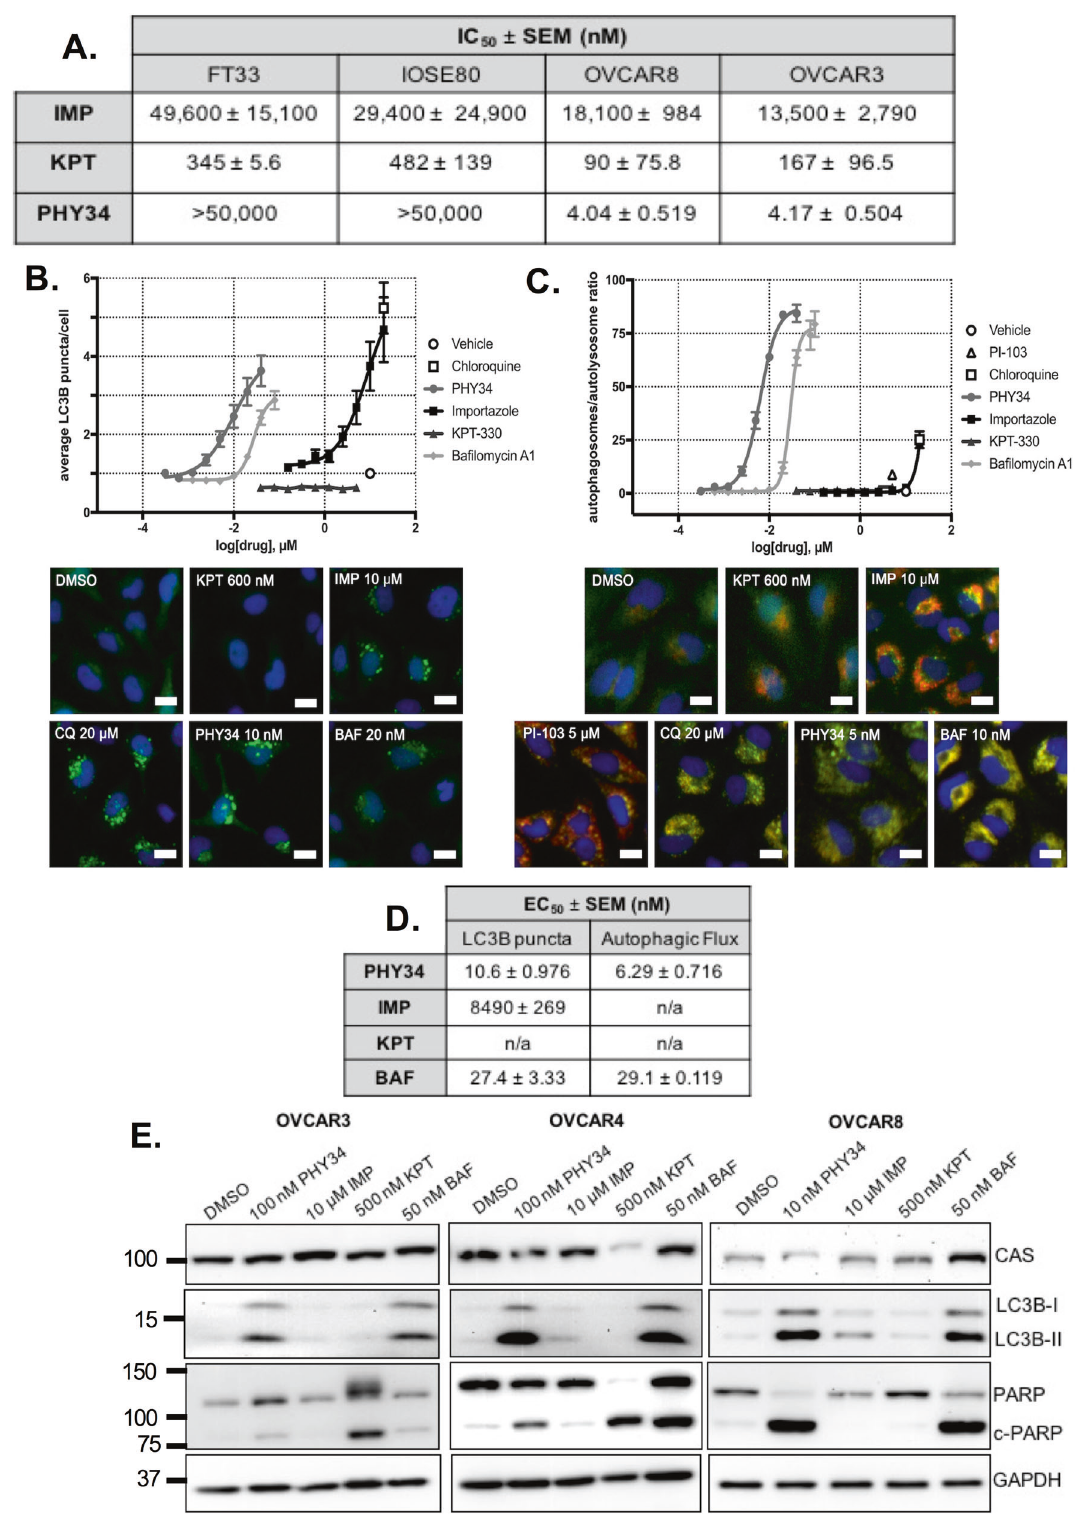
Fig. 3 PHY34 has a distinct mechanism of action than known nucleocytoplasmic transport inhibitors. A IC 50 values generated from dose- response curves measuring cell viability after 72 h treatment in HGSOC cell lines, OVCAR8 and OVCAR3, and non-tumorigenic cell lines, FT33 and IOSE80. SEM = standard error of the means. B Dose-response curves and representative images (scale bar = 20 μ m) for LC3B puncta assay conducted in eGFP-HeLa cells after 4 h treatment. C Dose-response curves and representative images (scale bar = 20 μ m) for autophagic fl ux assay conducted in mCherry-eGFP-HeLa cells after 24 h treatment. D EC 50 values generated from LC3B puncta and autophagic fl ux assays. SEM = standard error of the means. E Representative immunoblots for levels of CAS, autophagy biomarker (LC3B-II), and apoptosis biomarker (c-PARP) after PHY34 treatment in HGSOC cell lines, OVCAR3, OVCAR4, and OVCAR8.